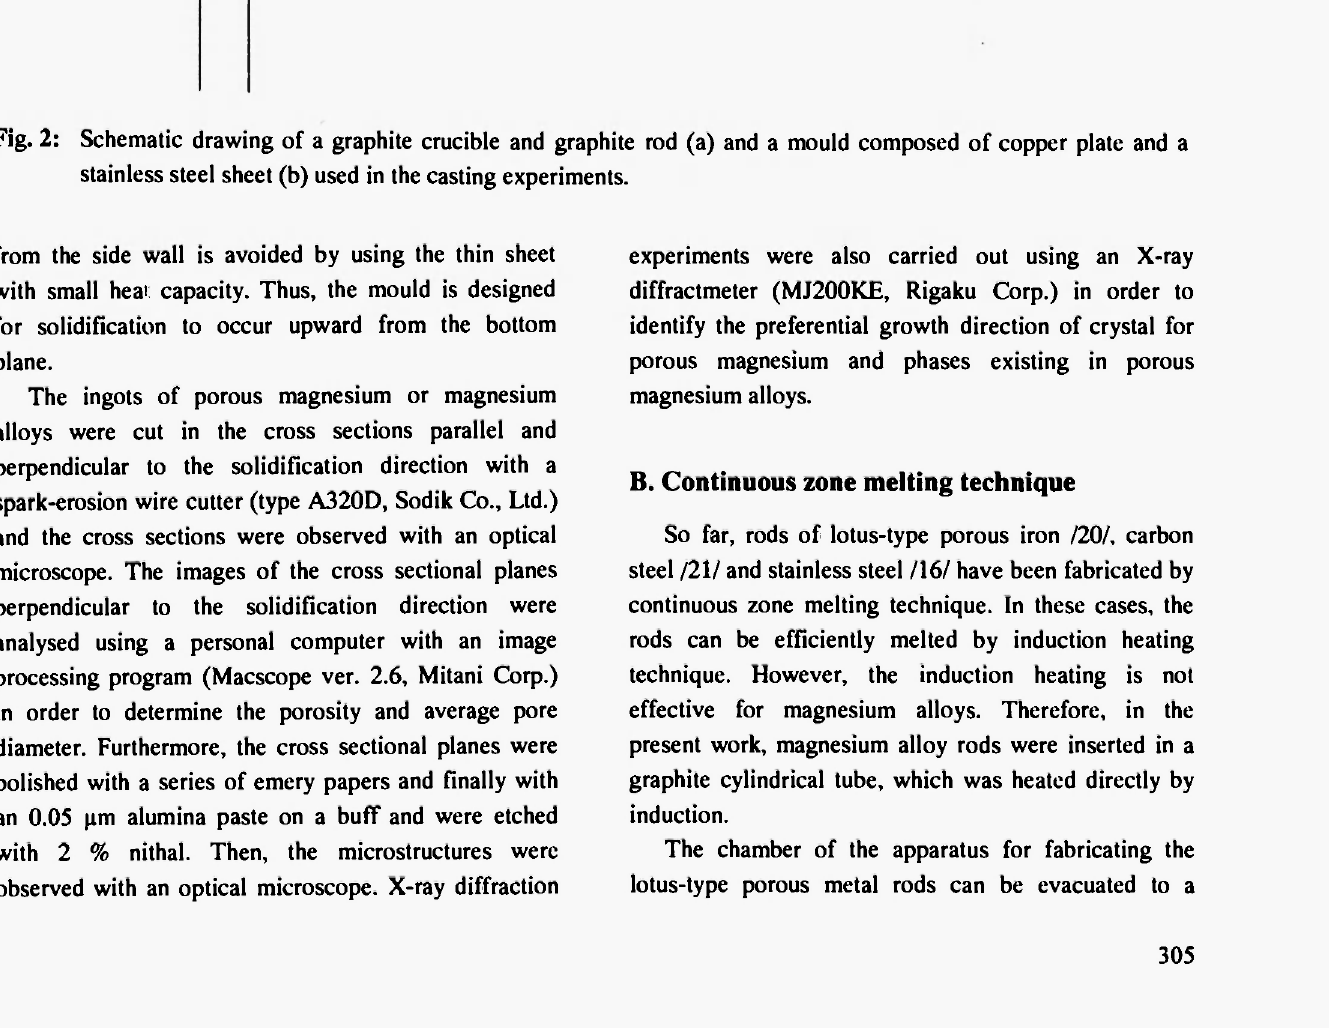
Fig. 2: Schematic drawing of a graphite crucible and graphite rod (a) and a mould composed of copper plate and a stainless steel sheet (b) used in the casting experiments.